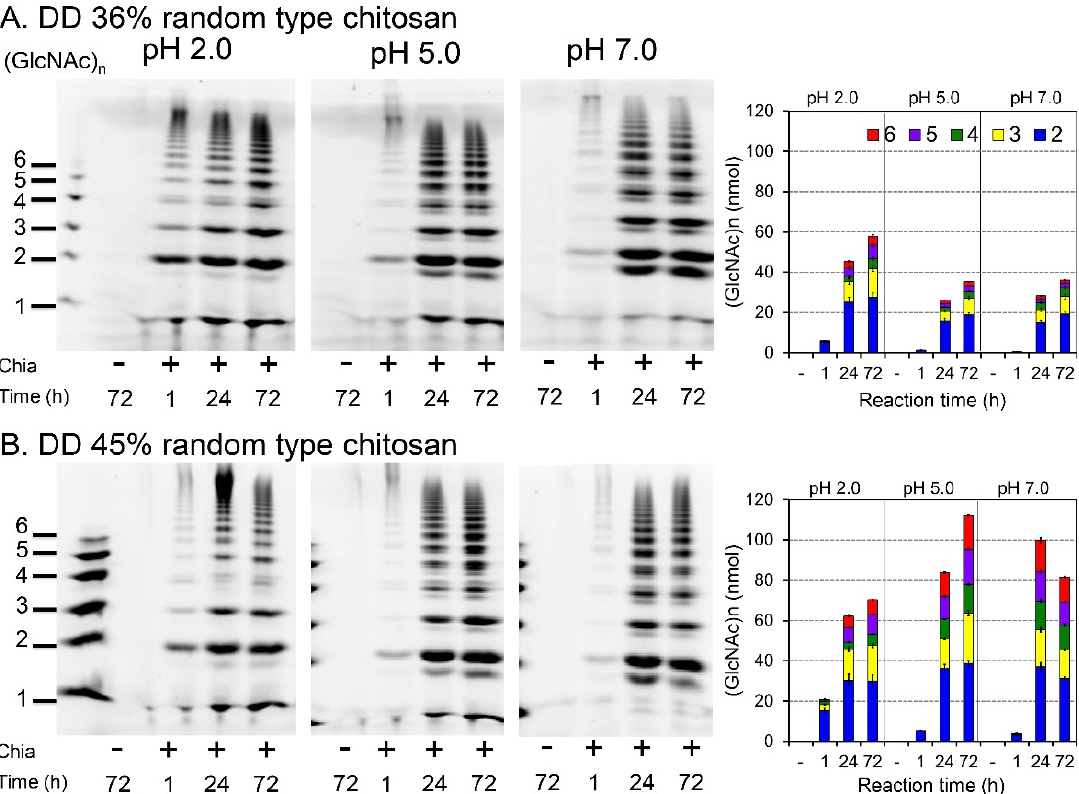
Figure 4. Degradation of random-type chitosan by Chia under different pH conditions. Chitosan was directly dissolved in water and incubated with Chia at pH 2.0, 5.0, or 7.0 and 37 °C for 1, 24, or 72 h, followed by the FACE method described in the Materials and Methods. Chitosan with DD 36% ( A ) and DD 45% ( B ) was used. Chitin oligomers are shown in the left margin as standards. Quantification of the data is shown in the right panels.